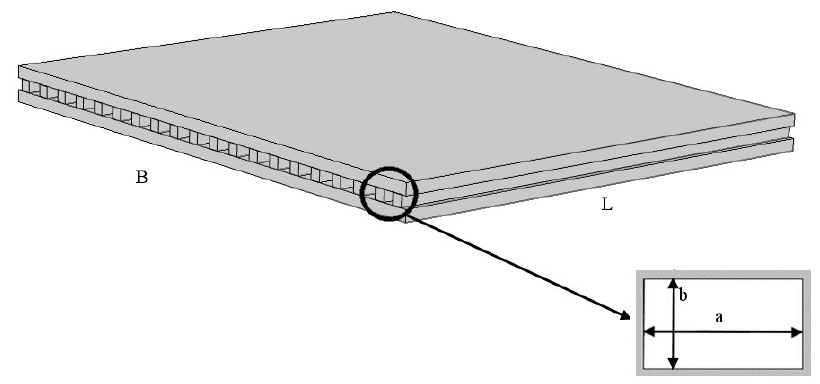
Figure 2. Sketch of the heat sink under investigation.